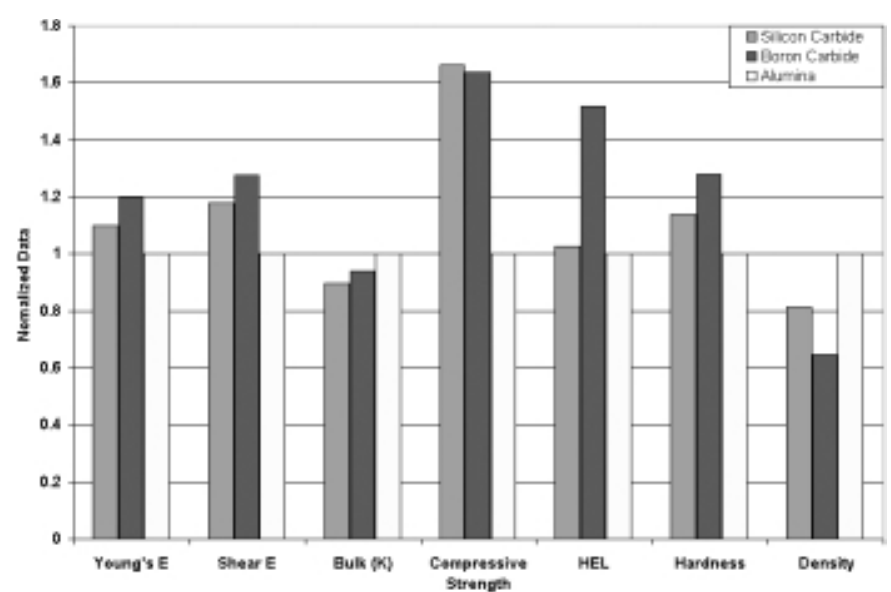
Fig. 3. Ceramic Properties Normalized by 99.9% Al 2 O 3